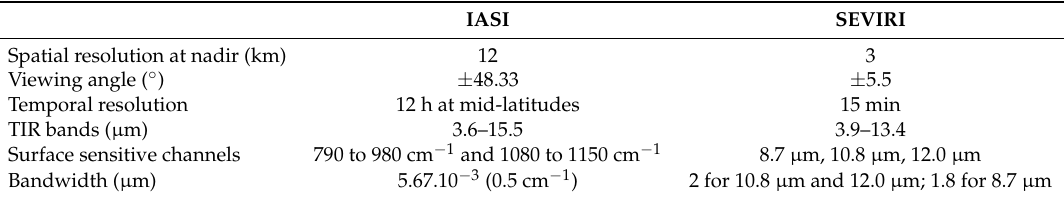
Table 2. IASI and SEVIRI main